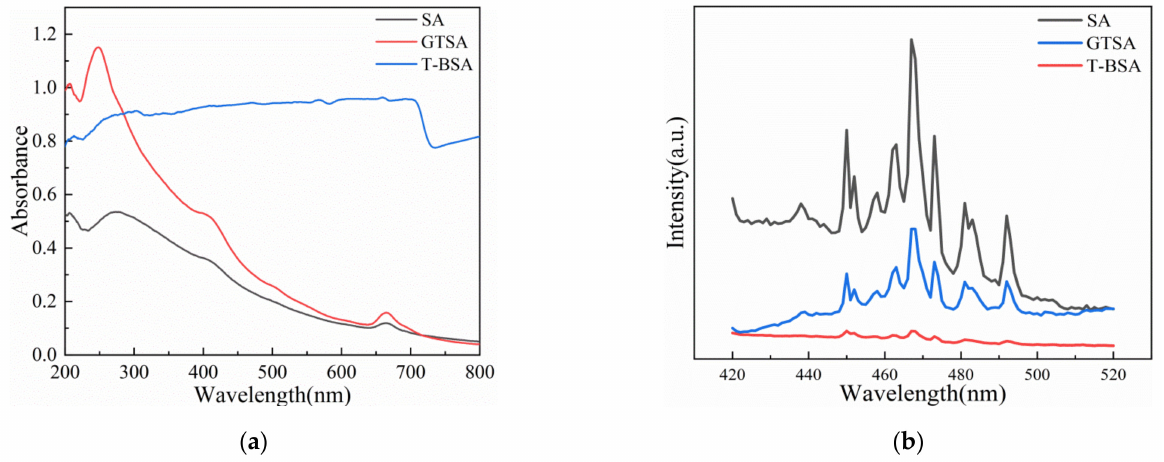
Figure 12. ( a ) UV-DRS spectra of SA, GTSA, and T-BSA; ( b ) photoluminescence spectra of SA, GTSA, and